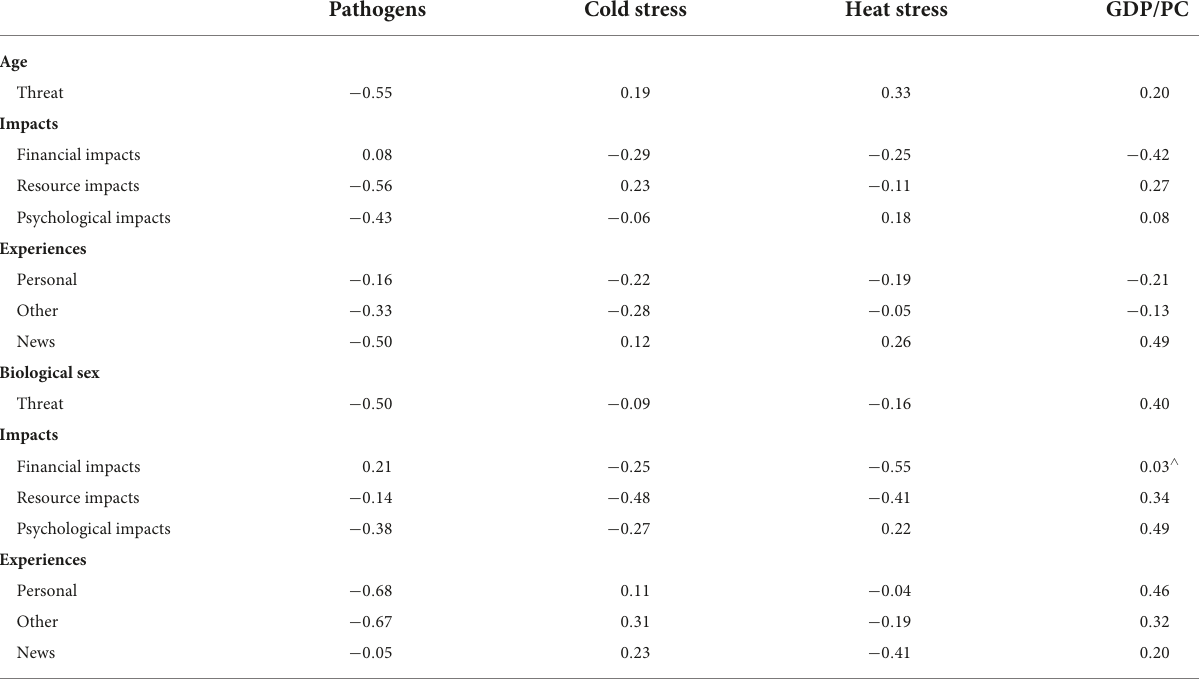
TABLE 8 Explaining culture-level variance: weighted correlations between culture-level socioecological variables and the relationships of age and biological sex with